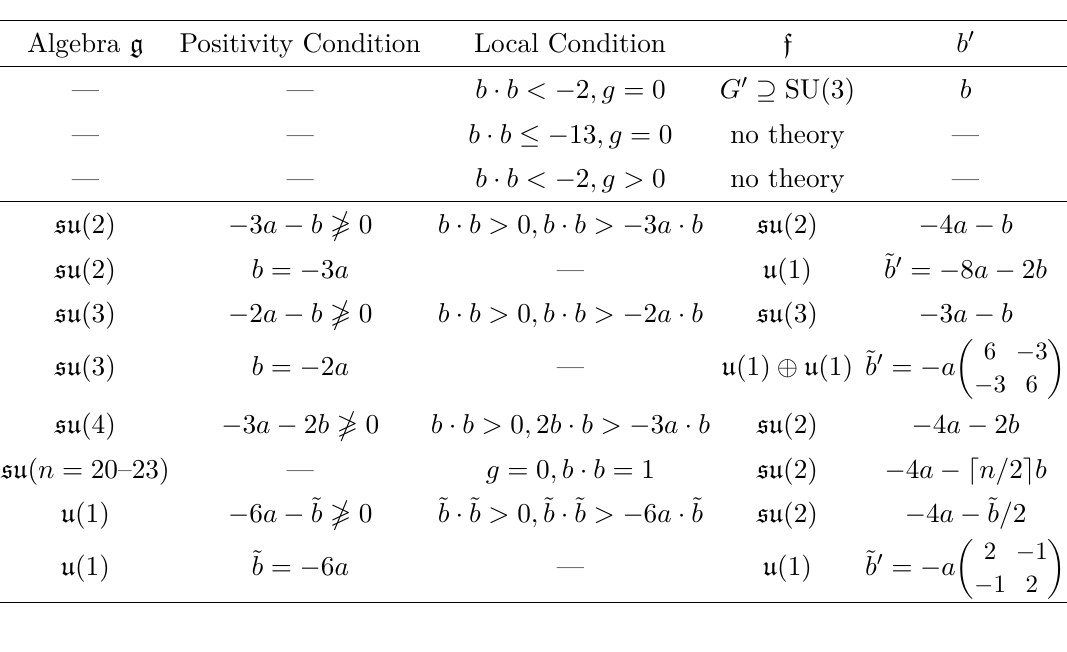
Table 4 . Positivity cone and local versions of the Automatic Enhancement Conjecture, for cases with generic matter. In each case a gauge component g with anomaly coefficient b satisfying cer- tain conditions forces enhancement to an additional gauge component of at least f with anomaly coefficient b 0 . (For u (1) factors, anomaly coefficients are ˜ b, ˜ b 0 respectively; note that this anomaly coefficient corresponds to the normalization of the u (1) factor so that all charges are integers.) The “genus” contribution g is given in terms of local anomaly coefficients a, b by eq. (3.2). In the “Pos- itivity Condition” column, which gives the conditions on divisor classes under which enhancement occurs, the notation D (cid:11) 0 means that the divisor class D is